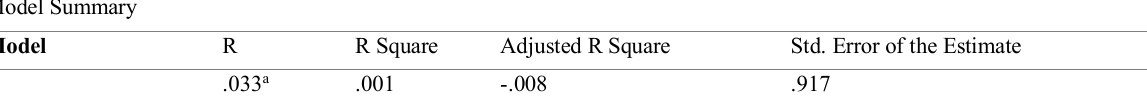
Table 3: Regression model summary for supportive leadership style